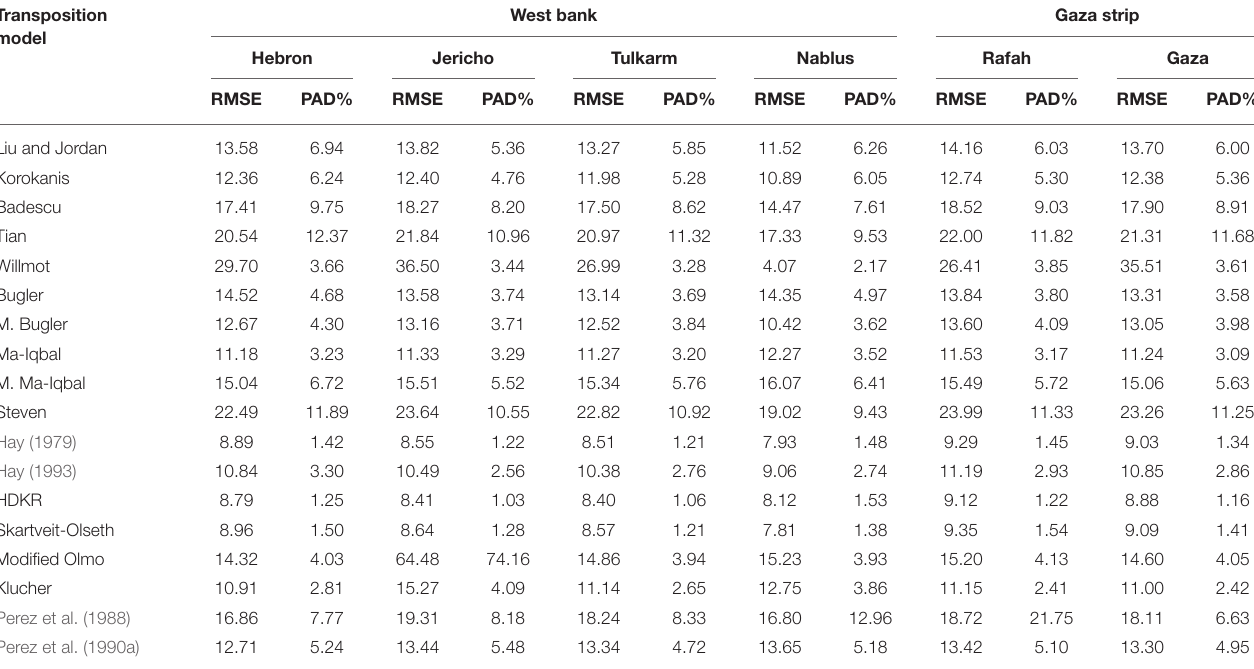
TABLE 3 | RMSe and PAD of transposition models considered cities for a surface tilted 30 ◦ south facing. Transposition